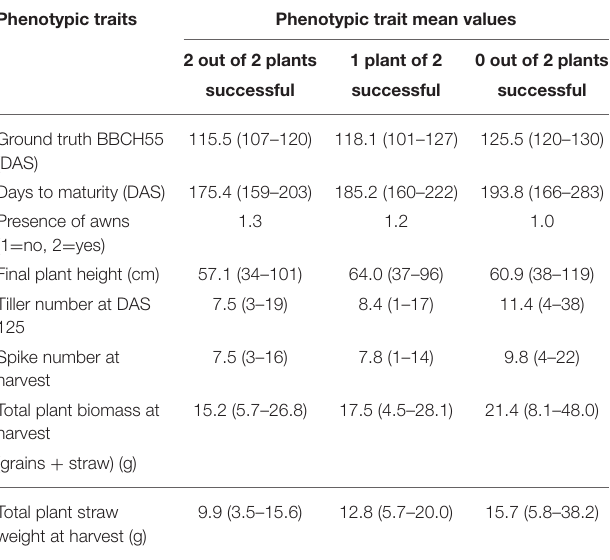
TABLE 3 | Gene classification and comparison of architectural features of 369